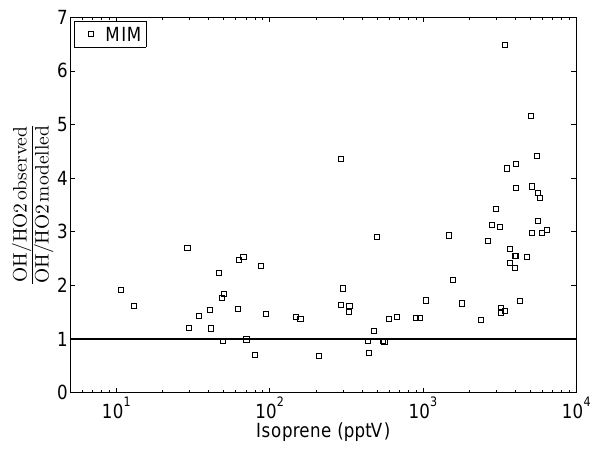
Fig. 15. Comparison of the ratio OH/HO 2 between observation and model as a function of isoprene.